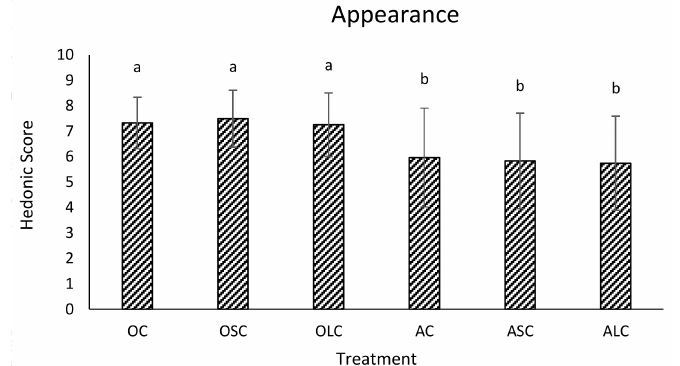
Figure 3. The hedonic scores (Mean ± SD) on the appearance of all 6 fruit juice samples from the panellists. The same letter above each bar graph indicates that there was no significant difference ( p > 0.05), while bar graphs with different letters indicate that there was a significant difference ( p < 0.05) according to Tukey’s studentized range test. OC, OSC, OLC (orange juice control, short chain and long chain inulin